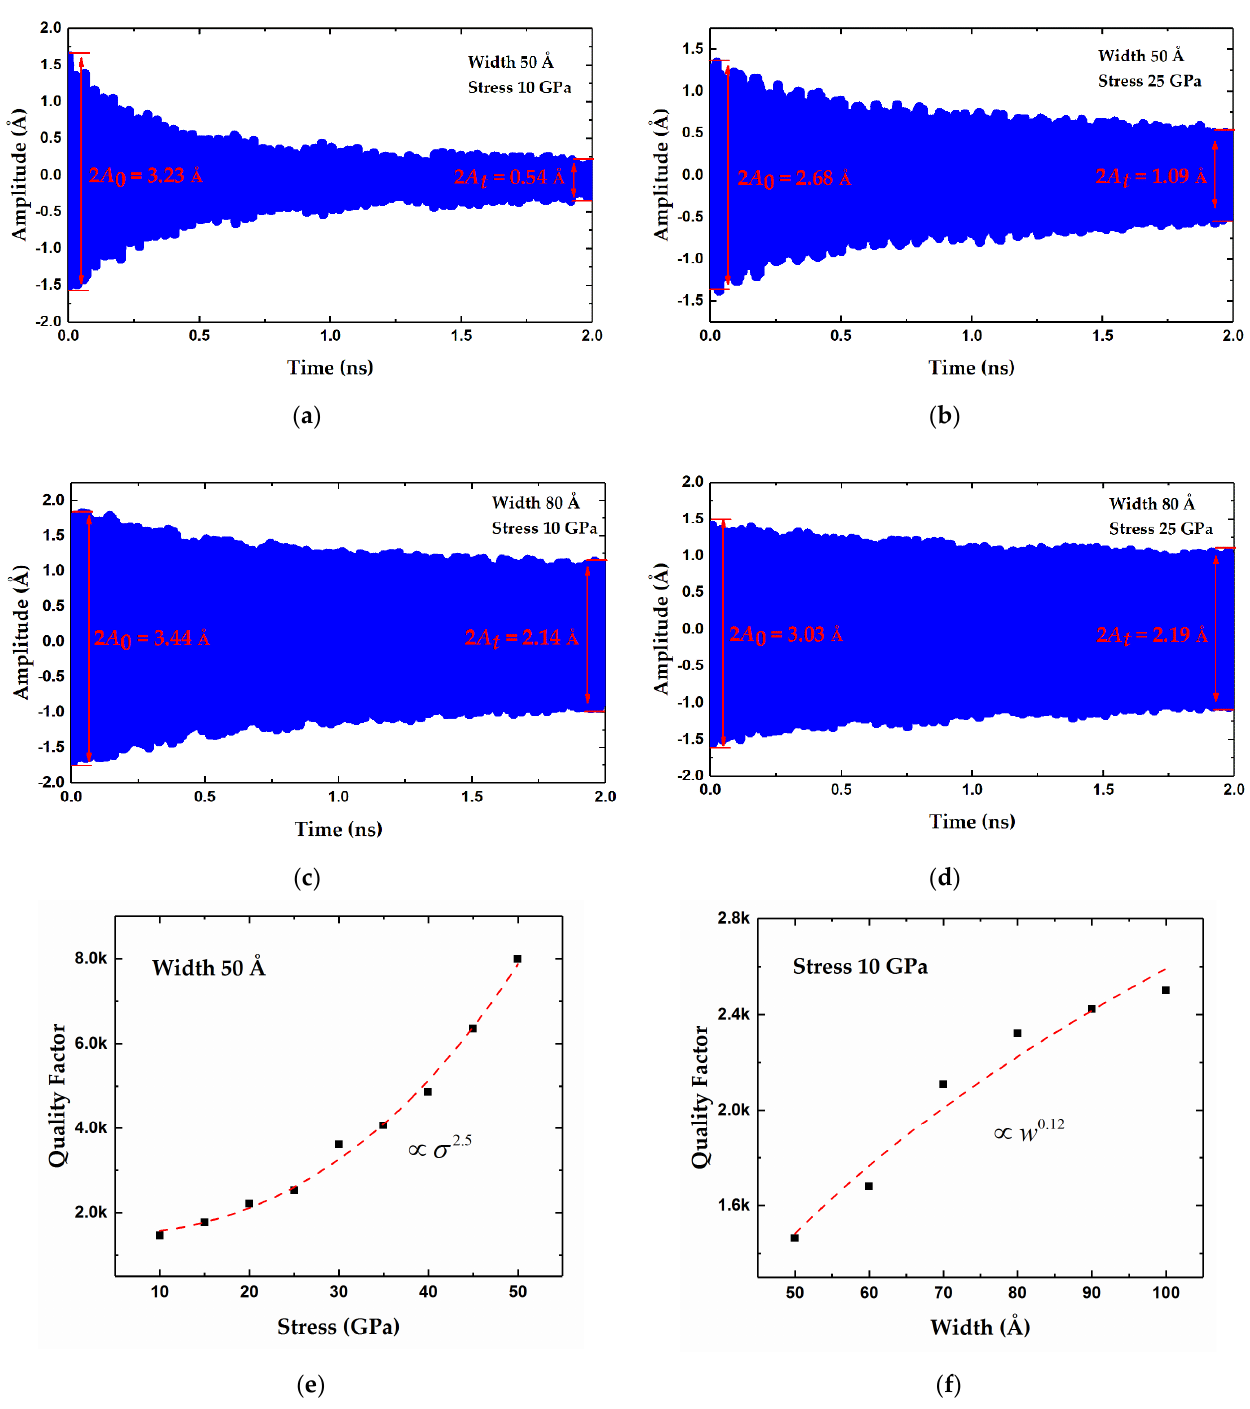
Figure 7. ( a – d ) Diminishing vibration amplitude with time for four graphene sheets with different widths and stress. ( a ) 50 Å, 10 GPa. ( b ) 50 Å, 25 GPa. ( c ) 80 Å, 10 GPa. ( d ) 80 Å, 25 GPa. ( e ) Q factor versus axial stress. ( f ) Q factor versus width.